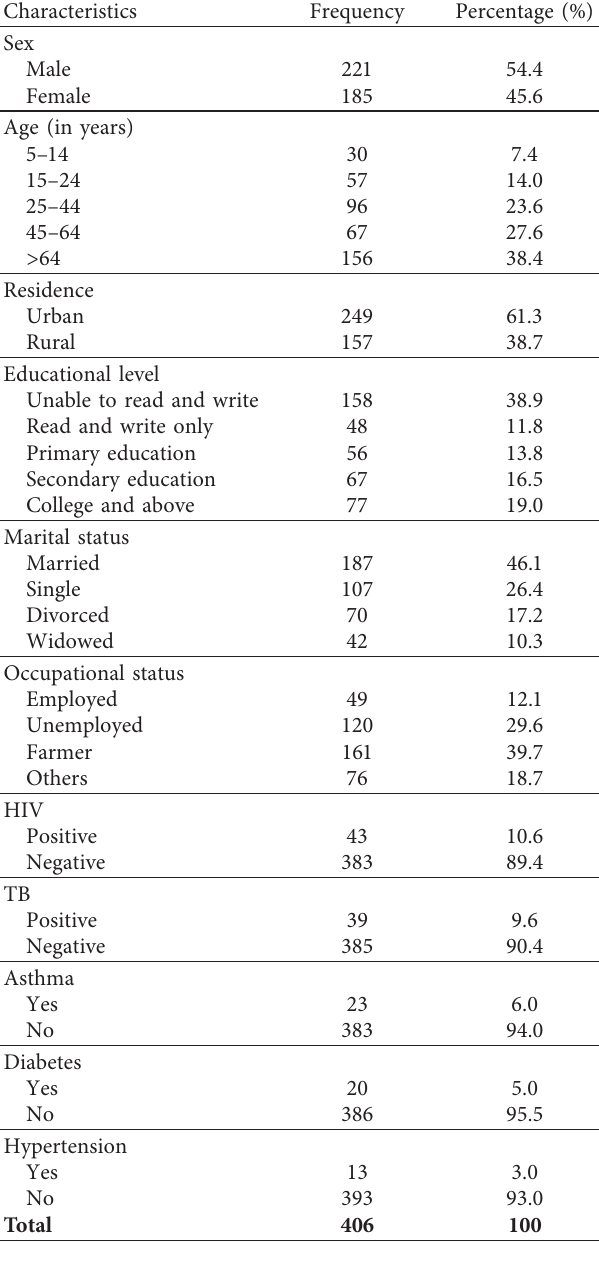
Table 1: Sociodemographic characteristics and clinical data of pneumonia suspected patients, Dessie,